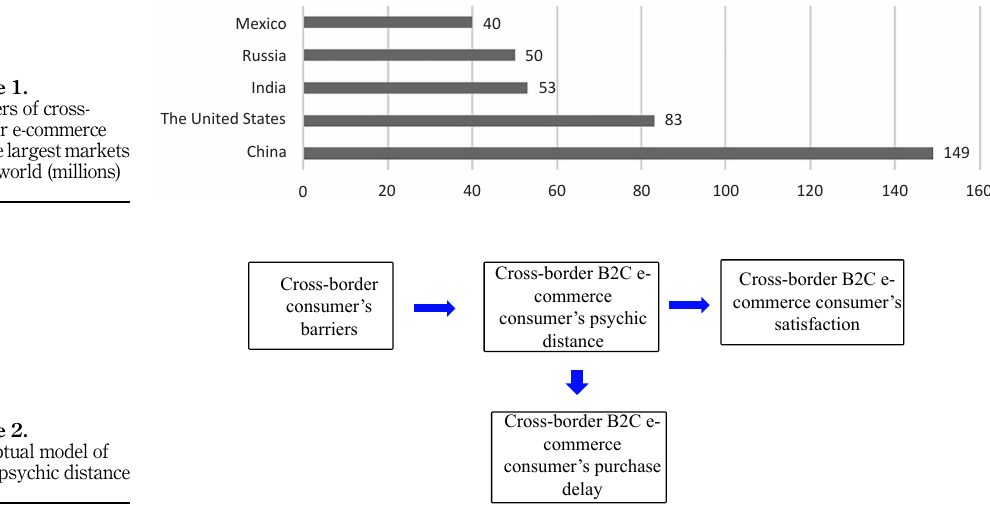
Figure 2. Conceptual model